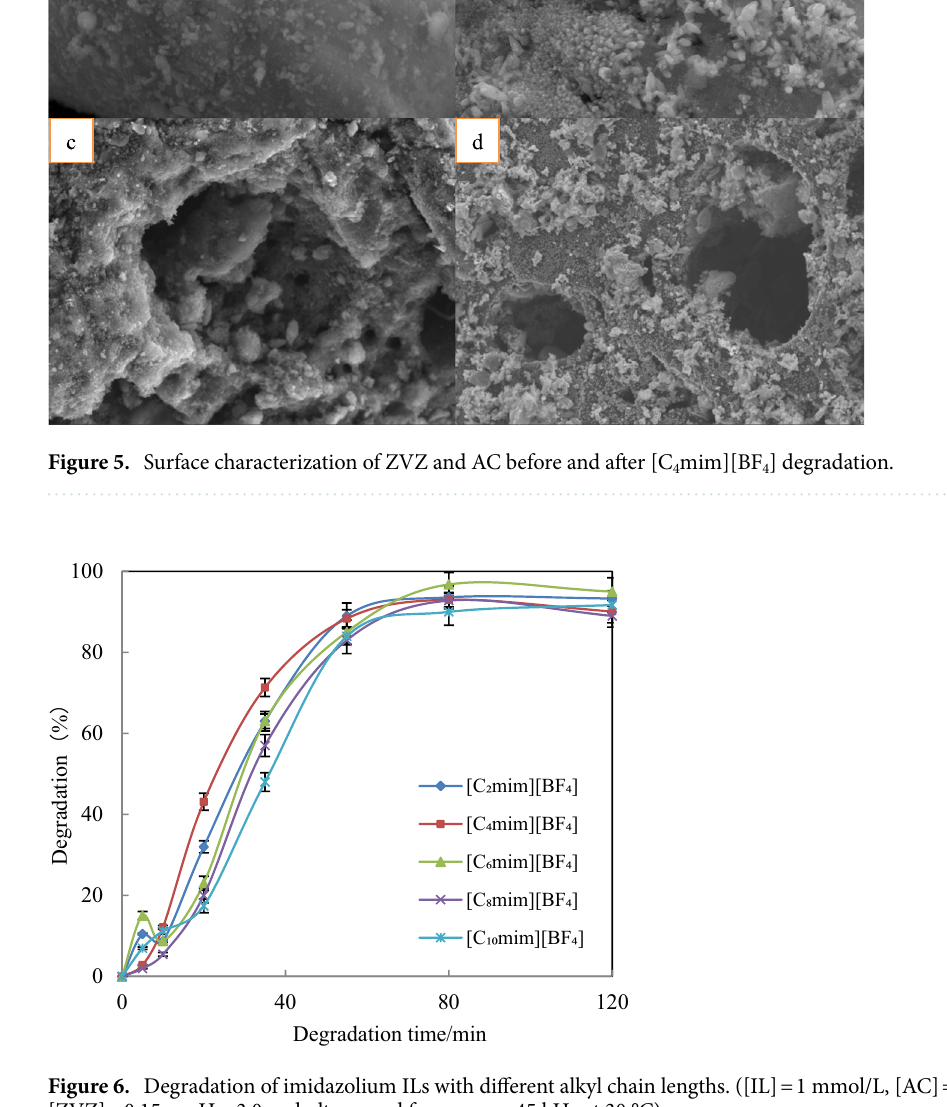
Figure 6. Degradation of imidazolium ILs with different alkyl chain lengths. ([IL] = 1 mmol/L, [AC] = 0.15 g, [ZVZ] = 0.15 g, pH = 3.0 and ultrasound frequency = 45 kHz at 30